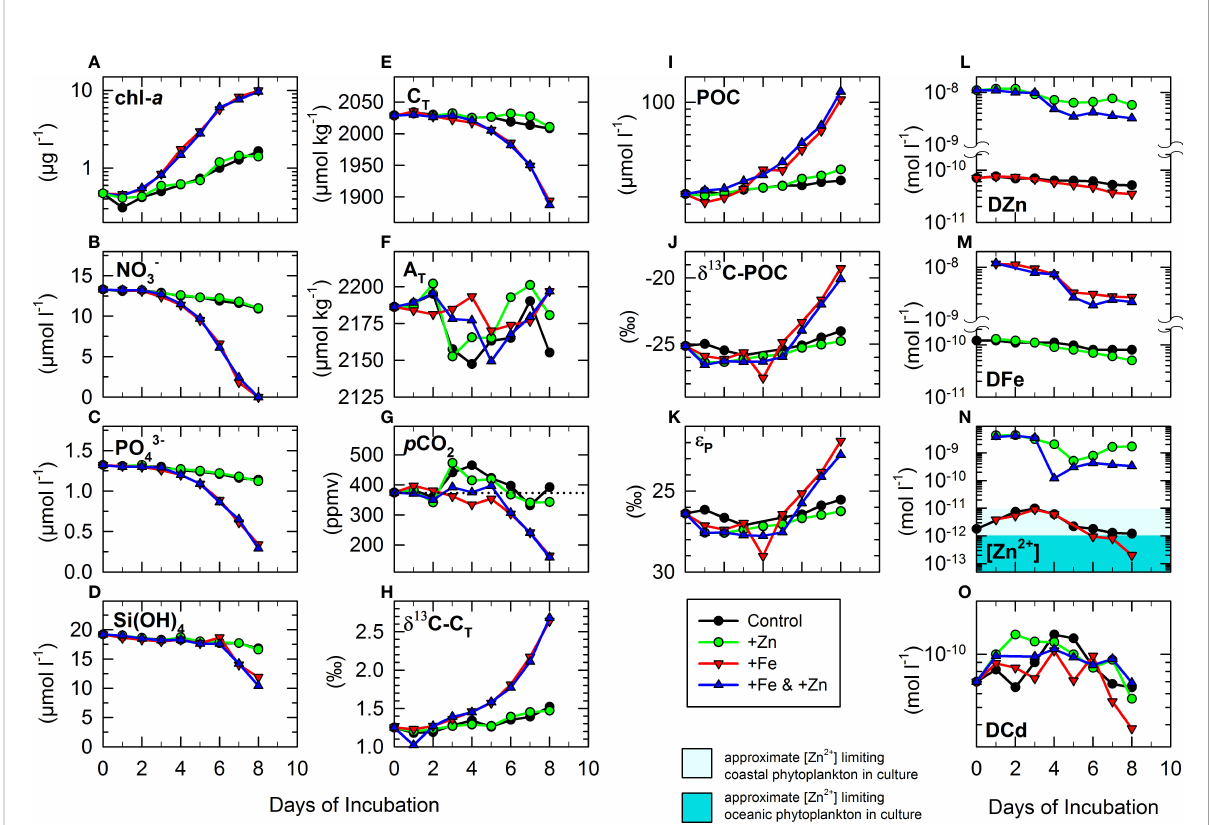
FIGURE 1 Time series of measurements during the 8-day on-deck incubations of cubitainers of seawater from Ocean Station Papa (OSP; 50°N 145°W). One set of incubations were un-supplemented (control), while the others were supplemented either with DZn (+Zn), DFe (+Fe), or both (+Fe & +Zn). The complete experiment represented (T 0 ) measurements, followed by daily sampling from the four treatments, with each data point representing one ~4-L incubation. Subsamples for the following measurements were taken, with abbreviations given in Table 1A: Standard measurements of biomass of phytoplankton and concentrations of macronutrients: (A) chl- a , (B) NO 3- , (C) PO 43- , and (D) Si(OH) 4 . Standard measurements of the dissolved CO 2 system: (E) C T , (F) A T , (G) p CO 2 , and (H) d 13 C-C T . p CO 2 was calculated from C T and A T assuming constant T = 7.3°C and S = 32.55 of the mixed layer at T 0 (see Methods ). The dotted line in (G) shows approximate atmospheric p CO 2 for June 2001 (~373 ppmv). Particulate matter and isotopic analysis: (I) POC (J) d 13 C-POC and (K) approximate fractionation factor ( ϵ p ) between d 13 C-C T and d 13 C-POC. Dissolved trace metals: (L) DZn, (M) DFe, (N) [Zn 2+ ], (O) DCd. Note that some concentrations are plotted on a log scale because of the large ranges resulting from trace metal supplementation. Areas shaded in two shades of cyan in (N) represent the approximate [Zn 2+ ] levels below which Zn limits growth of some coastal (~10 pmol L − 1 ) and oceanic (~1 pmol L − 1 ) phytoplankton in cultures (Brand et al., 1983; Sunda and Huntsman, 1992; Varela et al.,